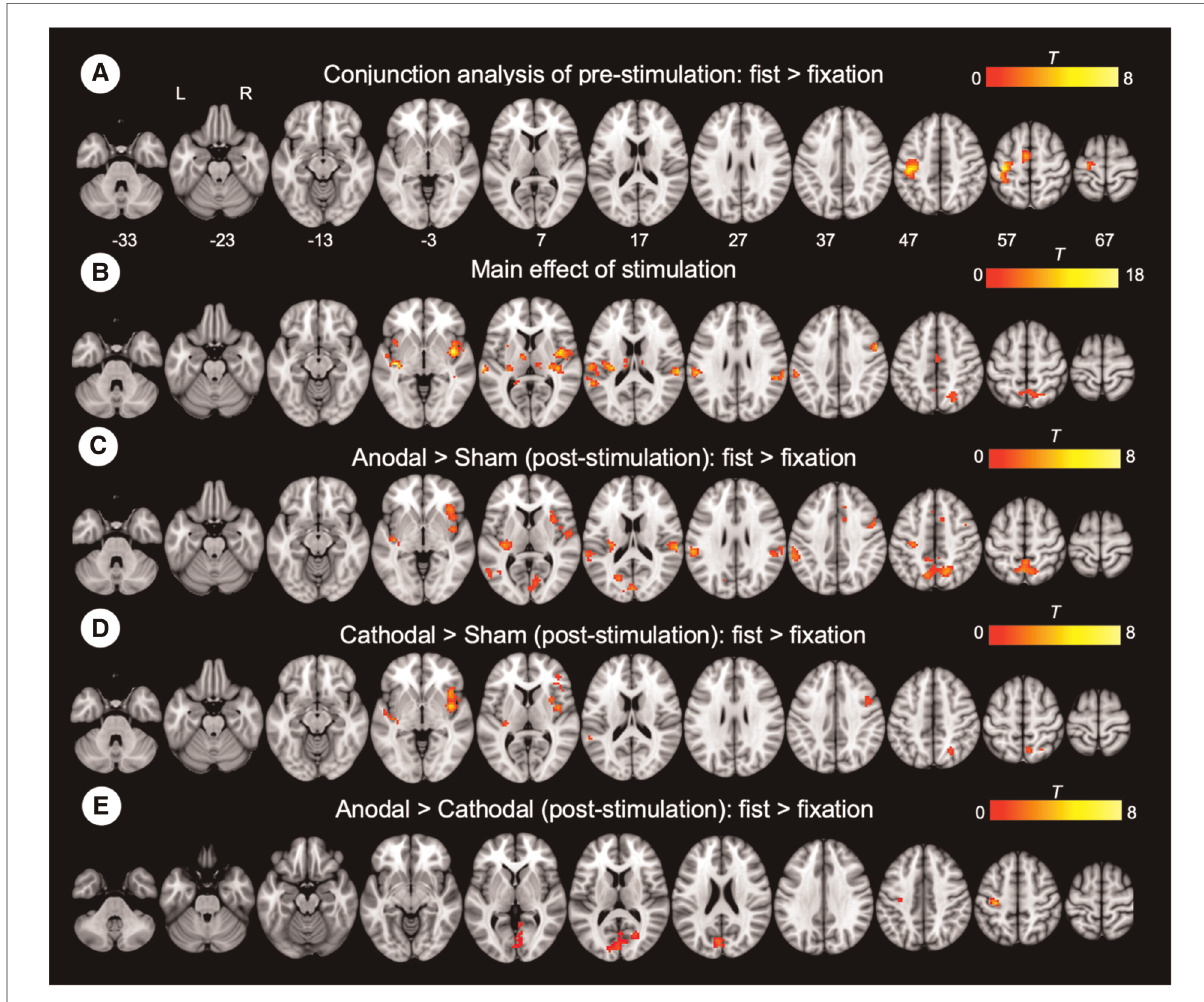
FIGURE 3 Whole-brain GLM results. ( A ) Conjunction analysis for the pre-stimulation task response across the groups. ( B ) Main effect of stimulation. ( C ) Comparison between anodal and sham group. ( D ) Comparison between cathodal and sham group. ( E ) Comparison between anodal and cathodal group. R (right) and L (left) indicate image orientations for slices in axial planes. Reference positions are in MNI coordinates. All images are displayed with a statistical signi fi cance of p <0.005 at the voxel level and p <0.05 (ks>30) at a cluster level with false-discovery rate (FDR)